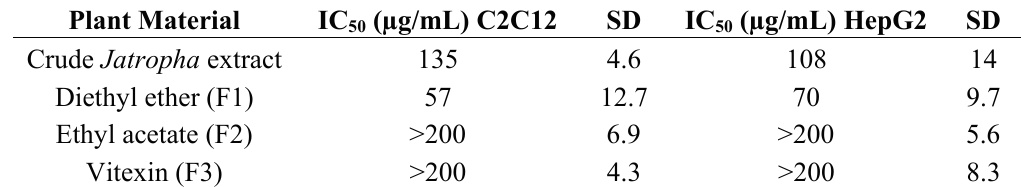
Table 1. IC 50 (cell viability) of the extracts . SD = standard deviation. Each experiment was completed in